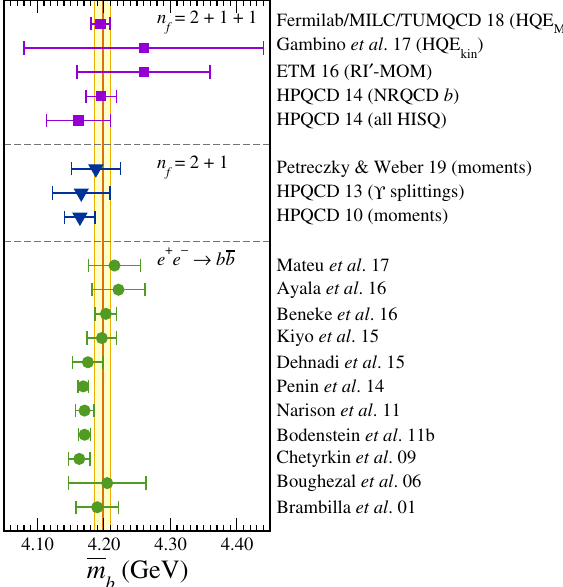
Fig. 4 Comparison of results for the bottom-quark mass ¯ m b = ( m ) (left) and the charm-quark mass ¯ m m b , MS b , MS (right).Squaresdenotelattice-QCDcalculationswith2 + 1 + 1flavorsof